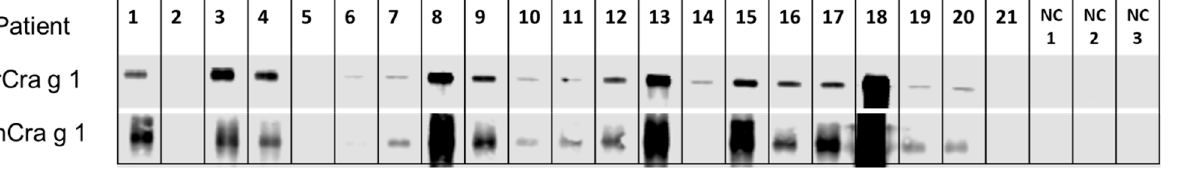
Figure 5. IgE reactivity analysis of natural and recombinant Pacific oyster TM using immunoblotting with 21 oyster-sensitised patients. rCra g 1 = purified recombinant Pacific oyster tropomyosin, nCra g 1 = purified natural Pacific oyster tropomyosin.